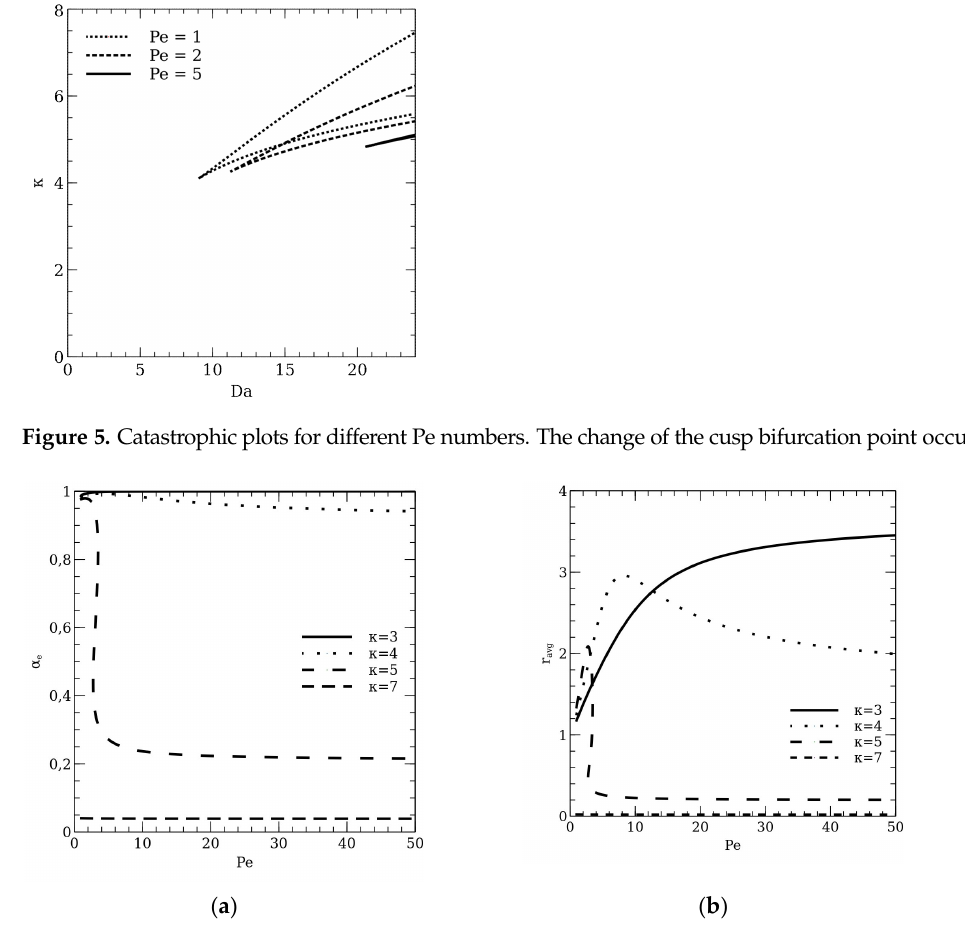
been presented in this figure: ( a ) the substrate conversion degree in the outlet stream; ( b ) the mean dimensionless reaction rate. The Damköhler number for these simulations is set on Da = 20